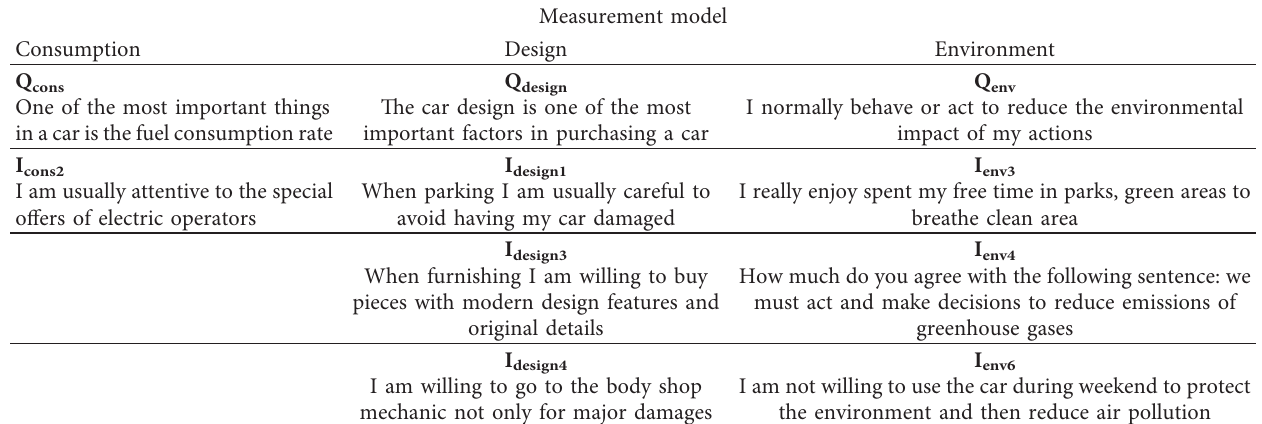
Table 8: Attitudes and indicators.